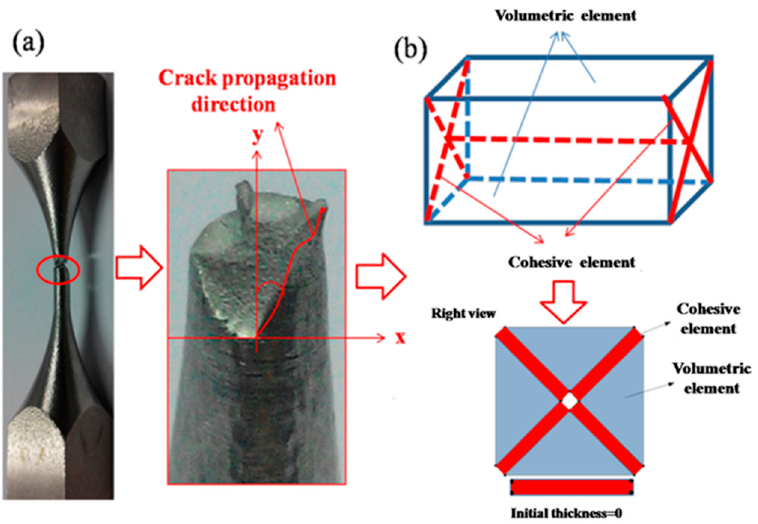
Figure 3. Cohesive elements insertion approach: ( a ) experimental observation of fatigue failure, ( b ) cohesive elements insertion.